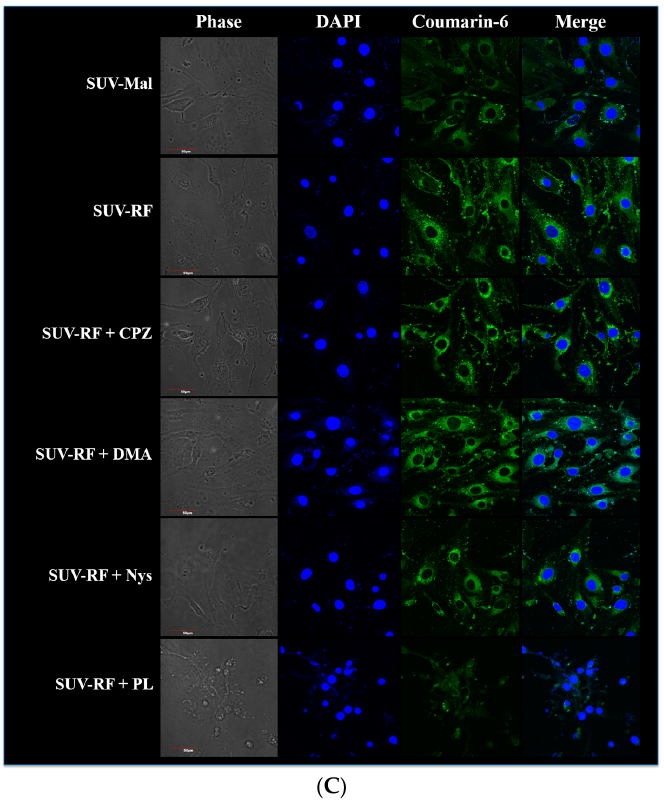
Figure 7. The cellular uptake mechanisms of SUV-RF. bEnd.3 cells were pre-treated with various endocytosis inhibitors including CPZ (10 µM, clathrin-mediated endocytosis inhibitor), DMA (20 µg/mL, macropinocytosis inhibitor), Nys (10 µg/mL, caveolae-mediated endocytosis inhibitor) and PL (250 µg/mL, positive-charged pathway) for 30 min and then incubated with coumarin-6-loaded SUV-RF for 90 min. Two methods including: flow cytometry ( A , B ); and confocal laser scanning microscope ( C ) were used to detect the relative fluorescence intensity and uptake images of internalized coumarin-6- loaded SUV-RF after treatment of different endocytosis inhibitors. Values are the mean ± SEM. ( n = 3). * p < 0.05, ** p < 0.01 compared to control by Student ′ s t -test analysis. Abbreviations: CPZ, chlopromazine hydrochloride; DMA, 5-( N , N -Dimethyl) amiloride hydrochloride; Nys, nystatin; PL, poly-lysine. Bar = 50